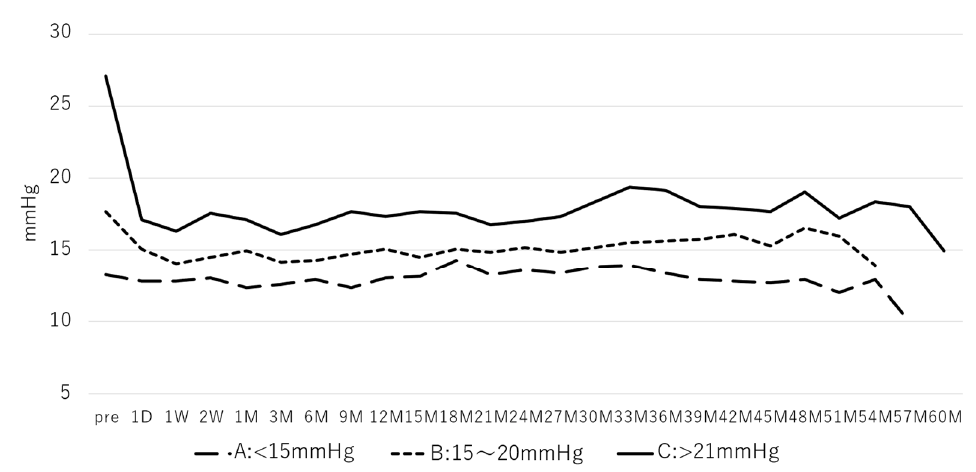
Figure 3. Postoperative changes: comparison by pre-IOP values: Group B: 15–20 mmHg and Group C: 21 mmHg or higher showed a significant decrease in postoperative IOP for the majority of the time periods (Group B: 1D-54 M ( p < 0.05), Group C: 1D-57 M ( p < 0.05)), whereas Group A: <15 mmHg showed no significant descent in all measurement periods (repeated ANOVA).